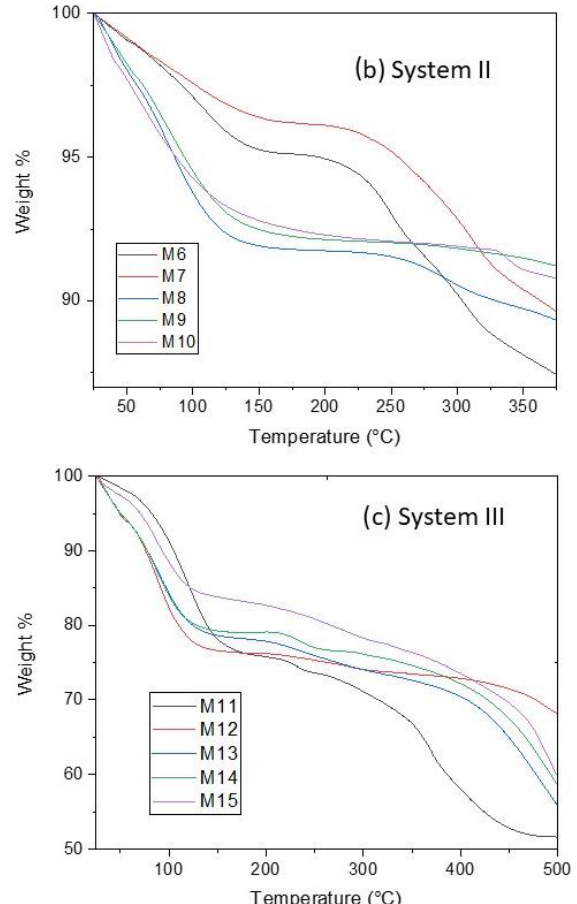
Figure 2. TGA results on CoHCFs for ( a ) system I; ( b ) system II; ( c ) system III.